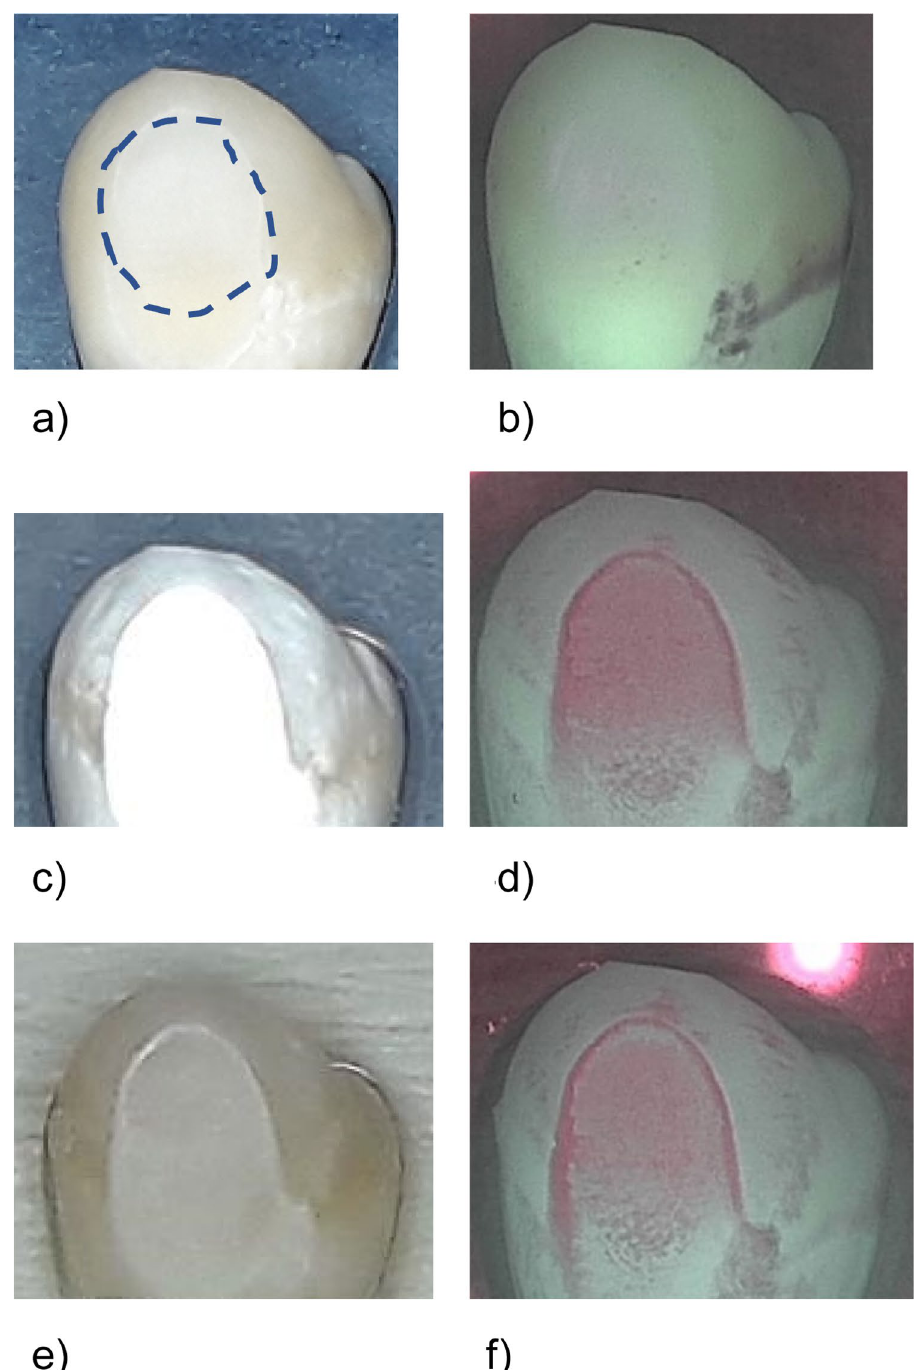
Figure 4. Standard image and QLF image of a representative sample in the negative control group (no treatment, sample #09) at different investigation times. The dashed line indicates the ground surface where the QLF measurements were performed. ( a ) Prior to demineralisation. ( b ) Corresponding QLF-image: ΔF = 0.0%; ΔFmax = 0.0%. ( c ) After demineralisation (T-demin). ( d ) Corresponding QLF-image (T-demin): ΔF = − 10.4%; ΔFmax = − 33.7%. ( e ) 28 days after demineralisation (T28). ( f ) Corresponding QLF-image (T28): ΔF = − 12.6%; ΔFmax = −